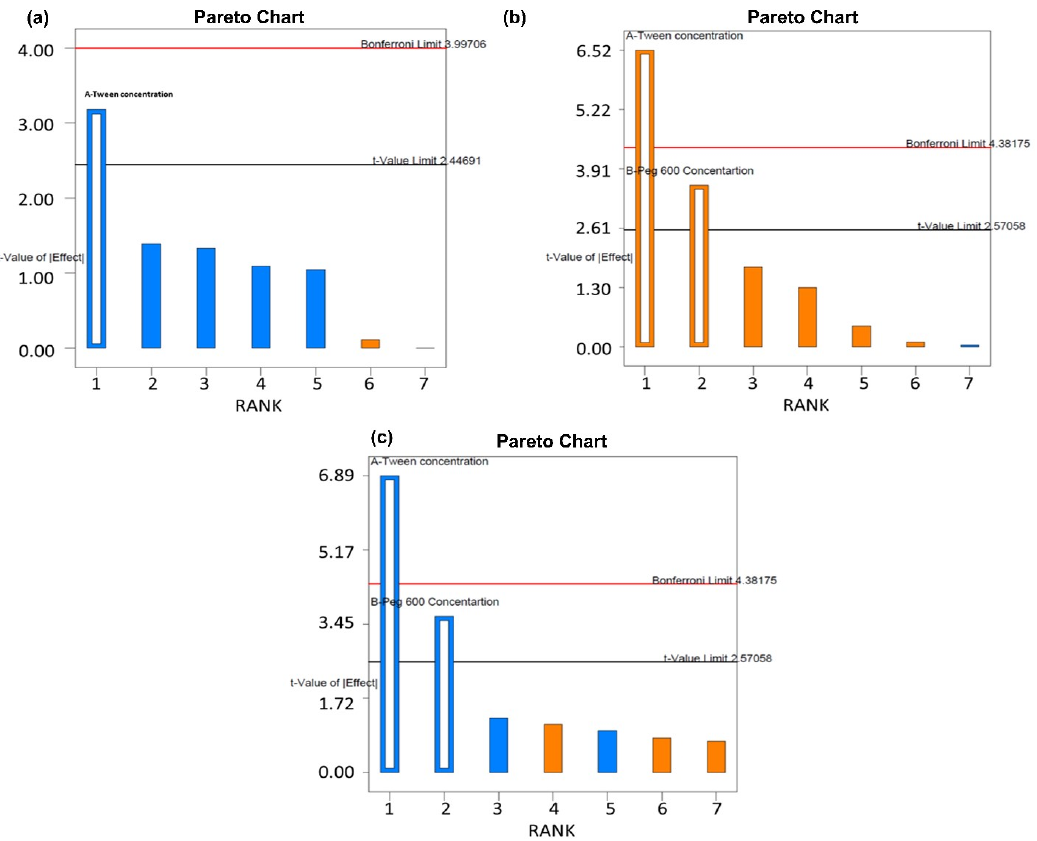
Figure 1. Pareto charts for response variable ( a ) particle size, ( b ) % entrapment efficiency, and ( c ) PDI.